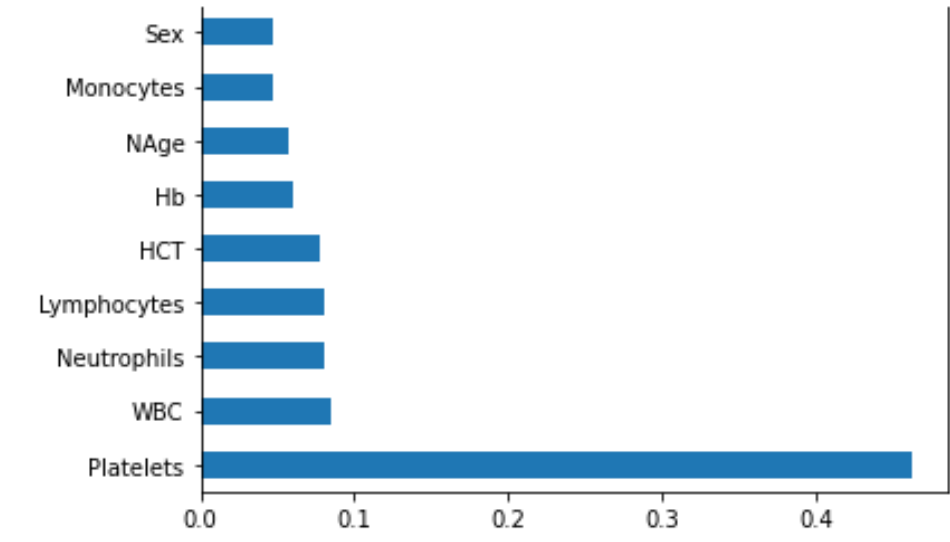
Figure 7. Bar diagram showing important features of the BDengue